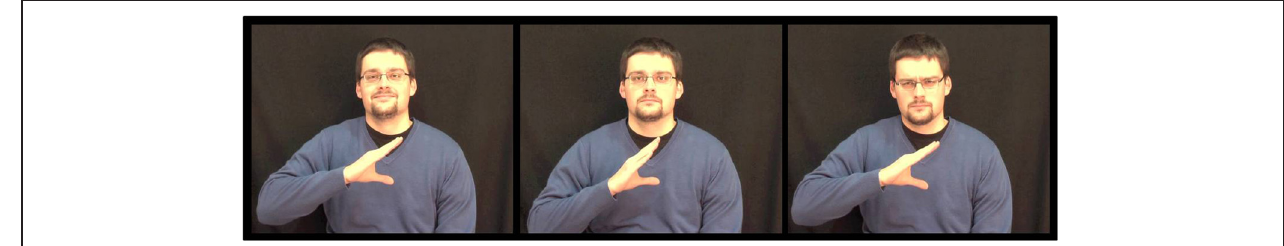
FIGURE 1 | Stills taken from stimulus video of one actor portraying from left to right: happy, neutral, and angry facial